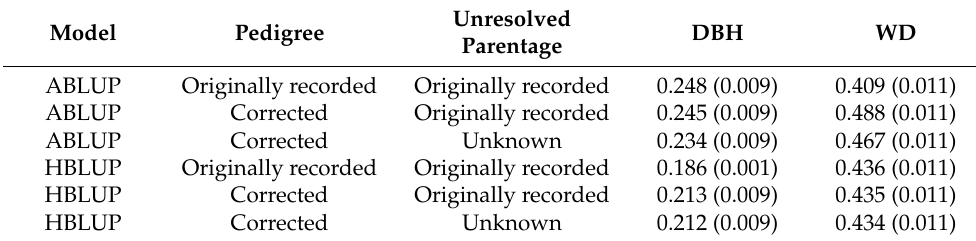
Table 2. Narrow-sense heritabilities ( h 2 ) and their standard errors (in parentheses) for diame- ter at breast height (DBH) and wood density (WD) from three different pedigree-based models (ABLUP) and three single-step blended prediction models (HBLUP) using the default weight (0.05) on pedigree information.